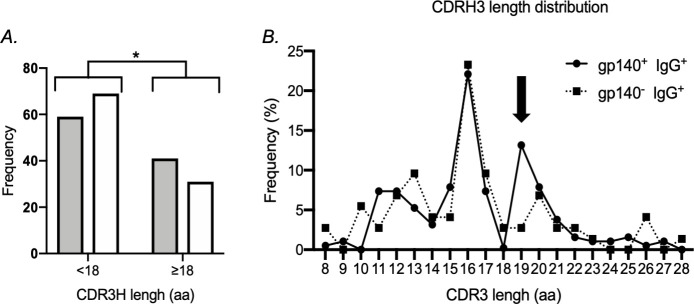
Characteristics of Complementarity Determining Region 3 of IgH (CDRH3) of human gp140+ and gp140- IgG+ B cells in vaccinated hu-mice.(A-B) Comparison of the CDRH3 amino-acid length between gp140+ specific and non-specific (gp140-) IgG+ antibodies of all immunized hu-mice. (A) Distribution of gp140+ (grey bar) and gp140- (white bar) IgG+ hu-B cells into two categories depending on whether the length of their CDRH3 was < 18 amino acids or ≥18 amino acids. Distributions were compared using Chi-Square tests. *p < 0.05. (B) CDRH3 length distribution in gp140+ (solid line) and gp140- (dotted line) IgG+ hu-B cells of all immunized hu-mice. The arrow highlights the main difference between the two populations of IgG+ human B cells.